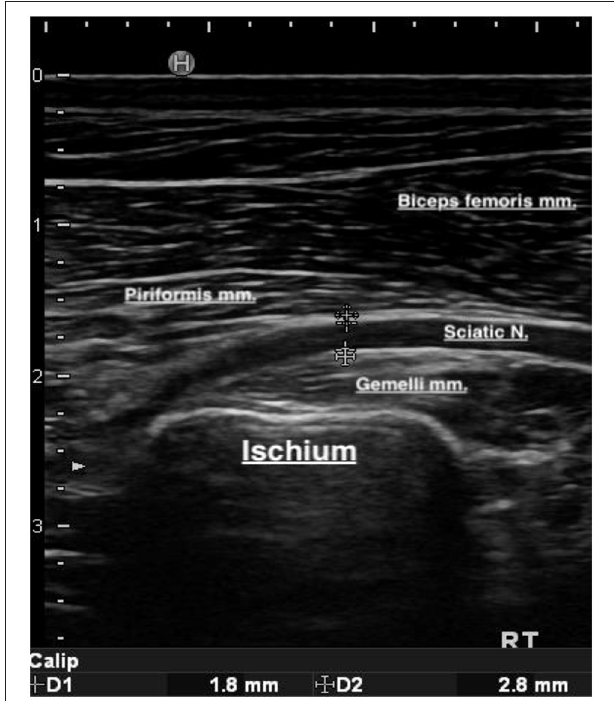
FIGURE 2 | Linear ultrasonography image of the sciatic nerve and the surrounding muscles. The inner and outer margins of the sciatic nerve have been measured. The inner margin (D1) is 1.8mm, and the outer margin (D2)